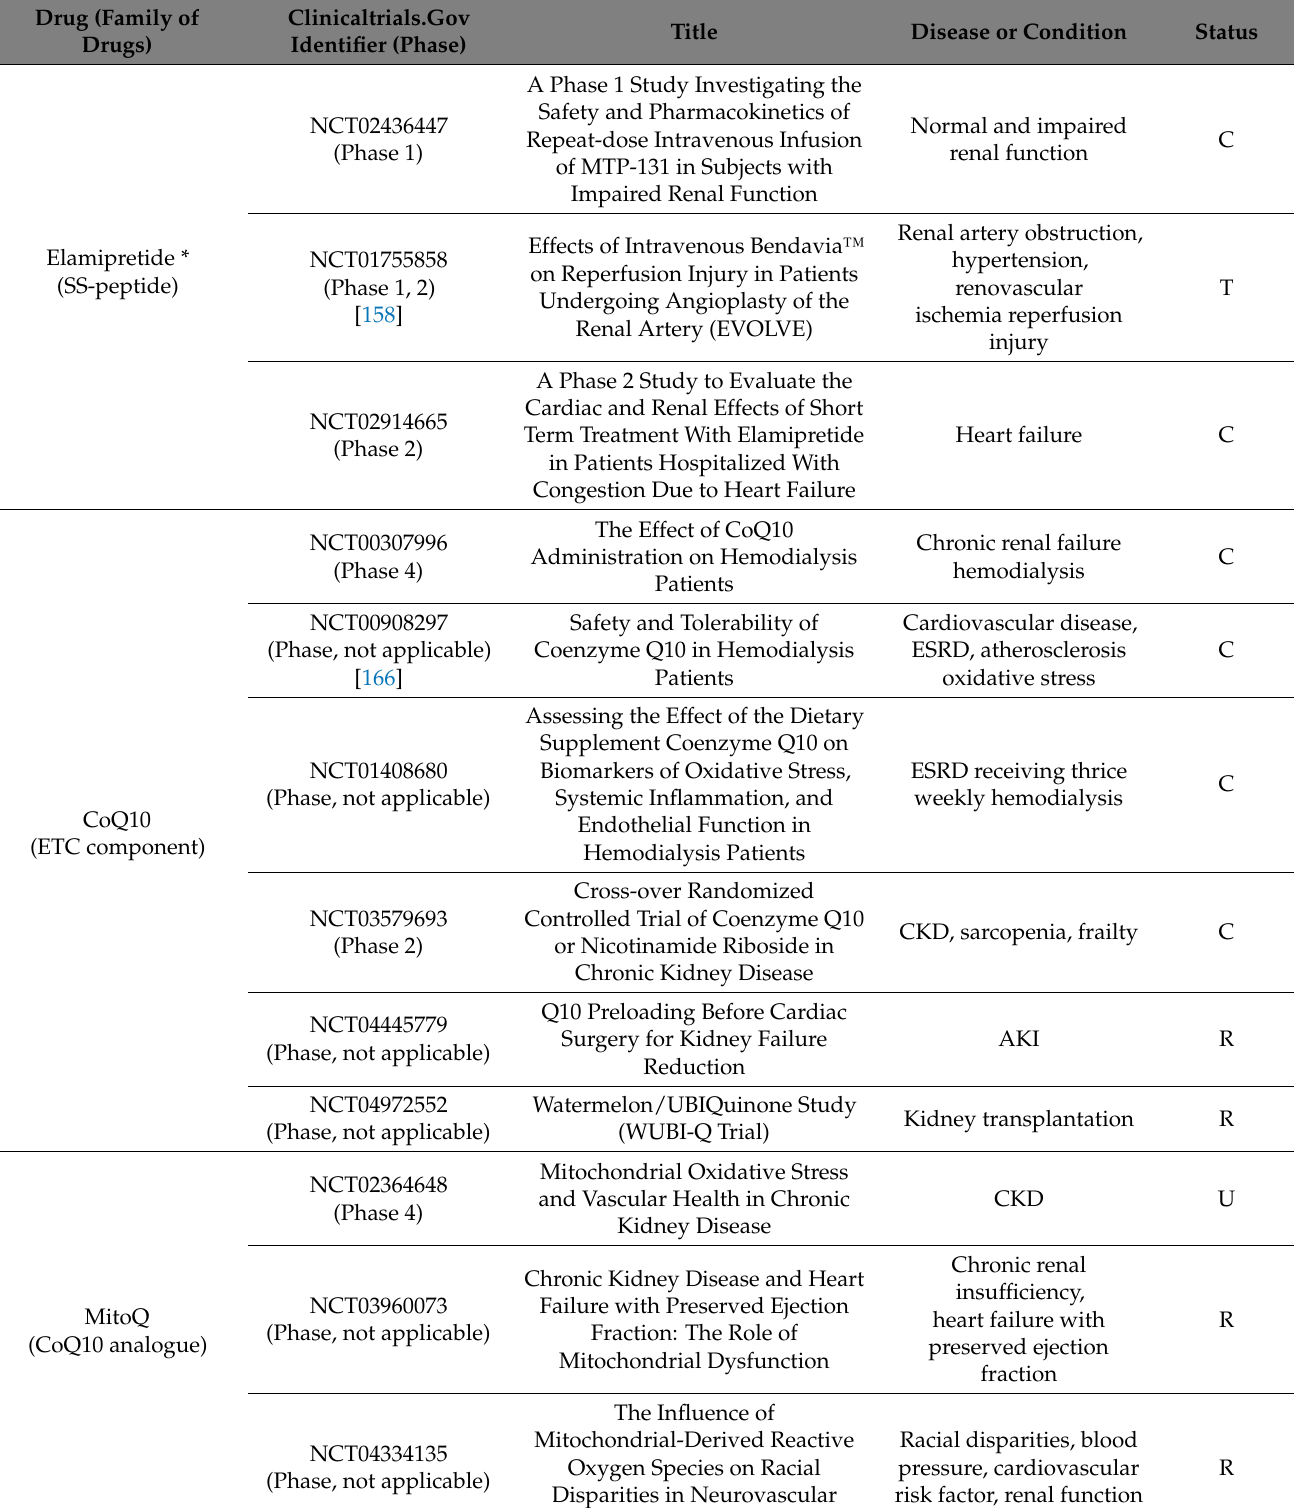
Table 3. Clinical trials related to kidney disease of drugs targeting mitochondria according to clinicaltrials.gov, accessed on 20 May